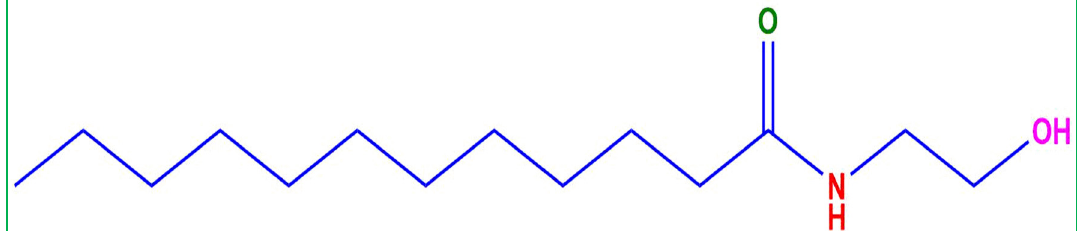
Figure 17. Molecular structure of coco mono ethanol amide (CMEA).